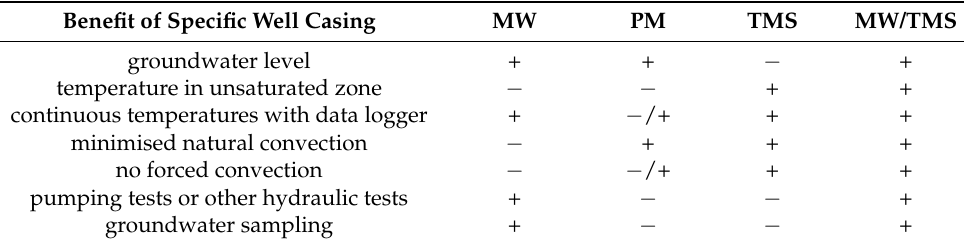
Table 4. Benefits and possible investigations of different kinds of well casings; MW = mon- itoring well with a diameter ≥ 50 mm; PM = Piezometer (small diameter with filter screen); MW/TMS = monitoring well and temperature measuring station combined in one borehole; TMS = non-screened temperature measuring station with small